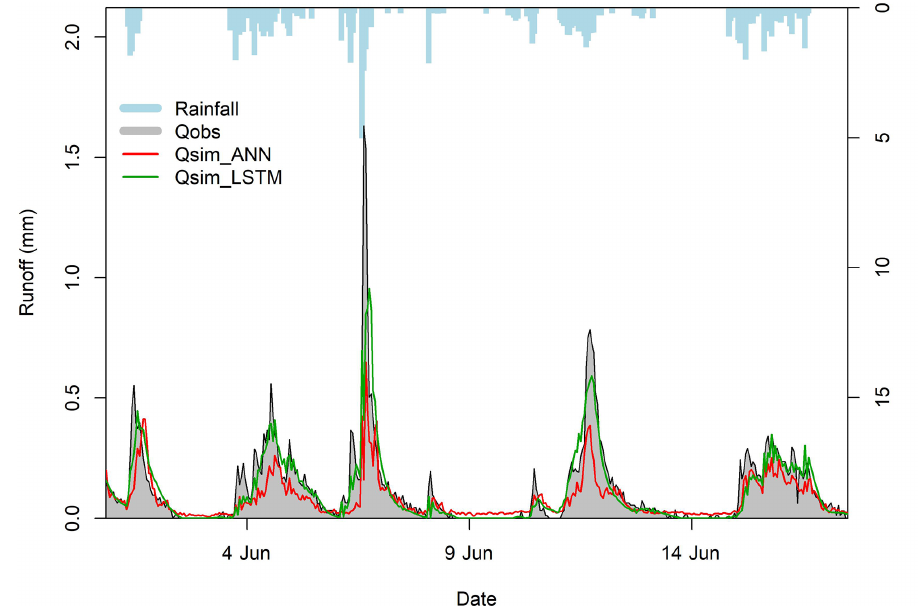
Figure 7. Comparison between LSTM and ANN at TRD1 roof.